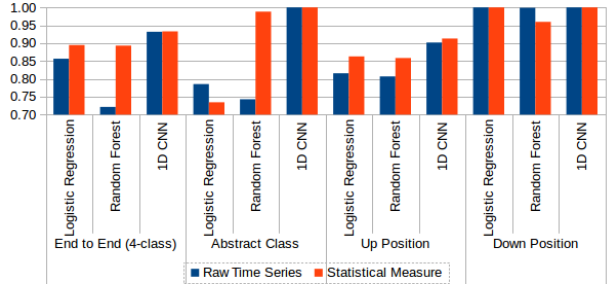
Figure 16. Comparison of raw time series (blue) and statistical feature (red) data performance without test data sharpening. Three machine learning classifiers, logistic regression, random forest, and 1D CNN, are compared on 4-class and various 2-class